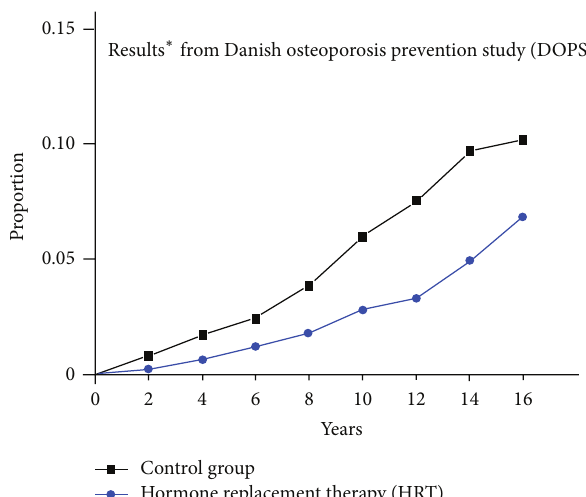
Figure 4: Cumulative hazard of developing death or hospitalization due to heart failure or myocardial infarction. ∗ Modified from Schierbeck